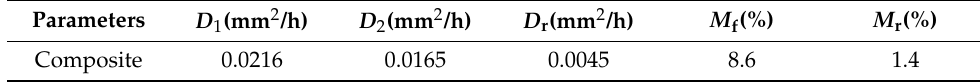
Table 4. The moisture diffusion parameters of the specimens.